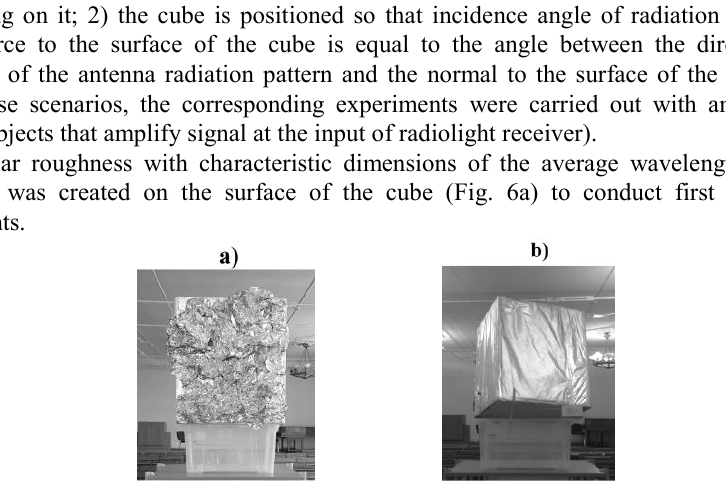
Fig. 6. Experiments with amplifying objects: a) a cube with a rough surface; b) a cube with a mirror surface that reflects the beam from the front face in the direction of the